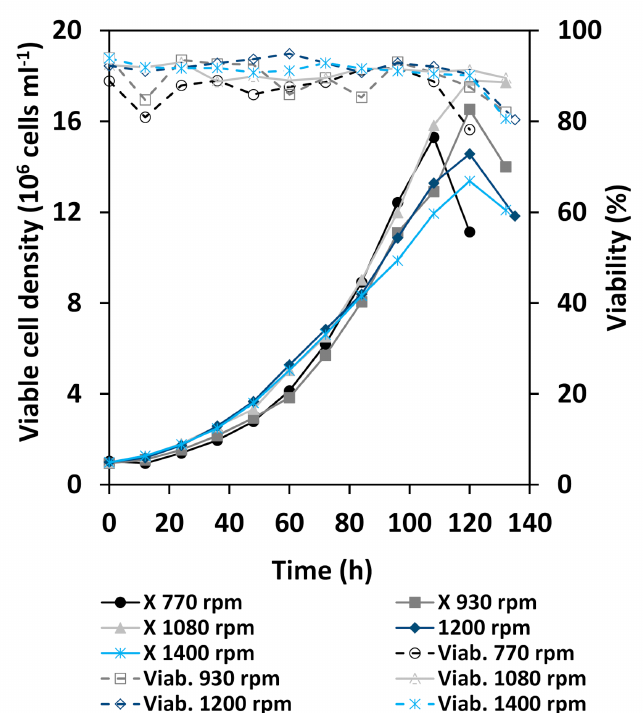
Figure 4. Growth curves (viable cell density X and viability) for the cultivations in the TIS at different agitation rates and respective averaged power inputs. The agitation rate settings range from 770 rpm